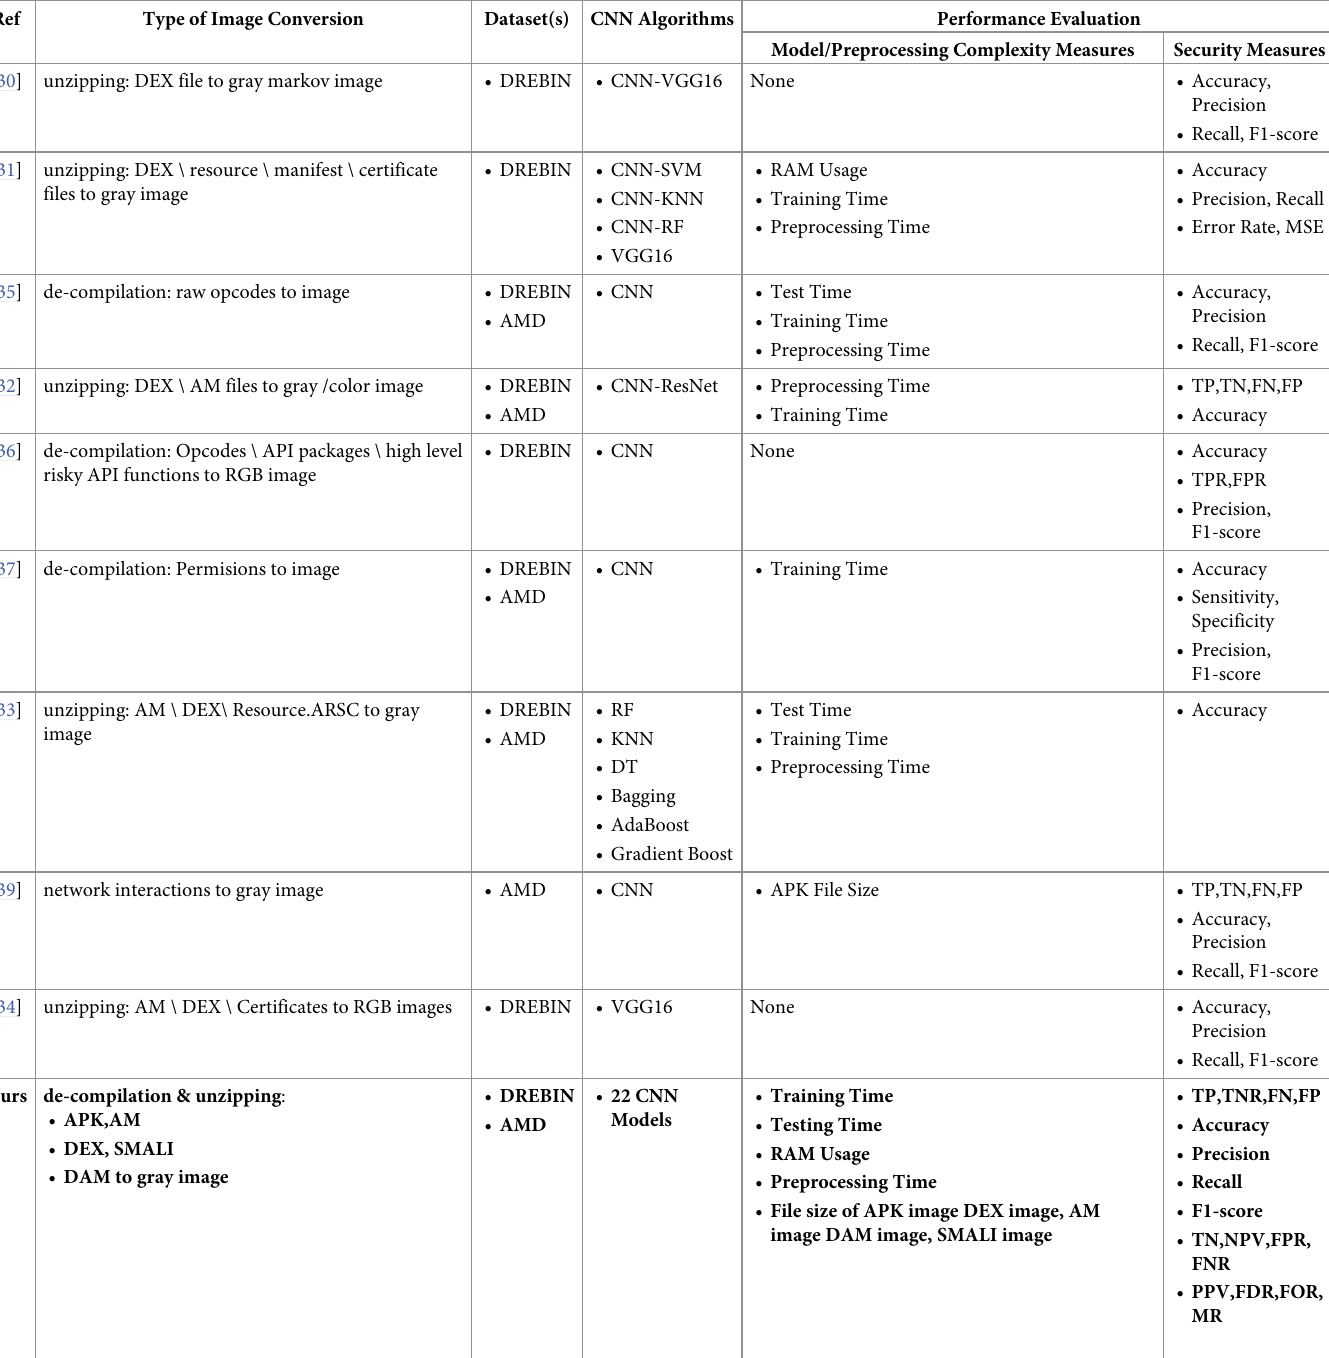
Table 1. Summary of recent related vision-based Android malware detection systems.